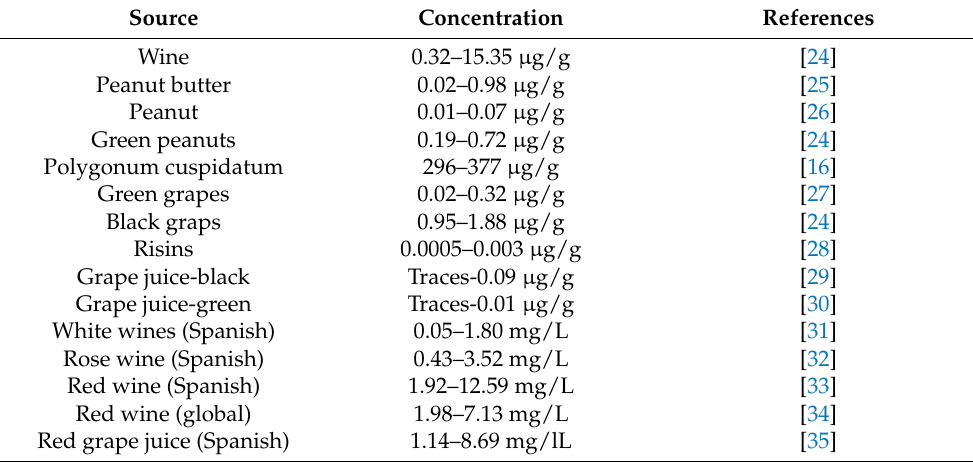
Table 2. List of Resveratrol sources with its